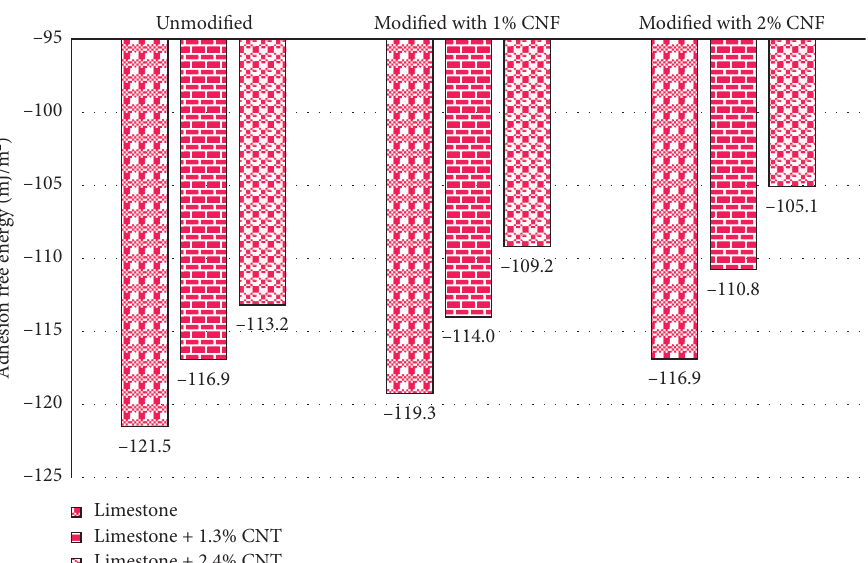
Figure 7: DE amounts of the aggregate and asphalt binder in the presence of